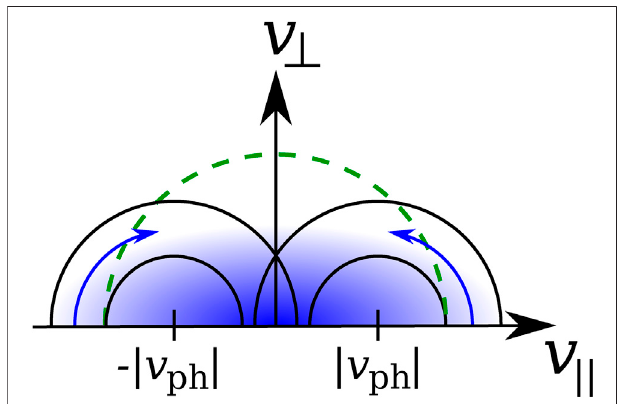
FIGURE 5 | Schematic illustration of the quasi-linear diffusion in the propagating electron fi rehose instability. The blue shaded area represents the anisotropic electron population with T (cid:2) e > T ⊥ e . The black semi-circles represent Eq. 17 for modi fi ed fast-magnetosonic/whistler waves with parallelphasespeed| v ph |(propagatinginthedirectionparallelto B 0 )and − | v ph | (propagating in the direction anti-parallel to B 0 ). The diffusive fl ux of cyclotron- resonantparticles isshown bythe blue arrows. The green-dashed semi-circle indicates v 2 ⊥ + v 2 (cid:2) (cid:3)